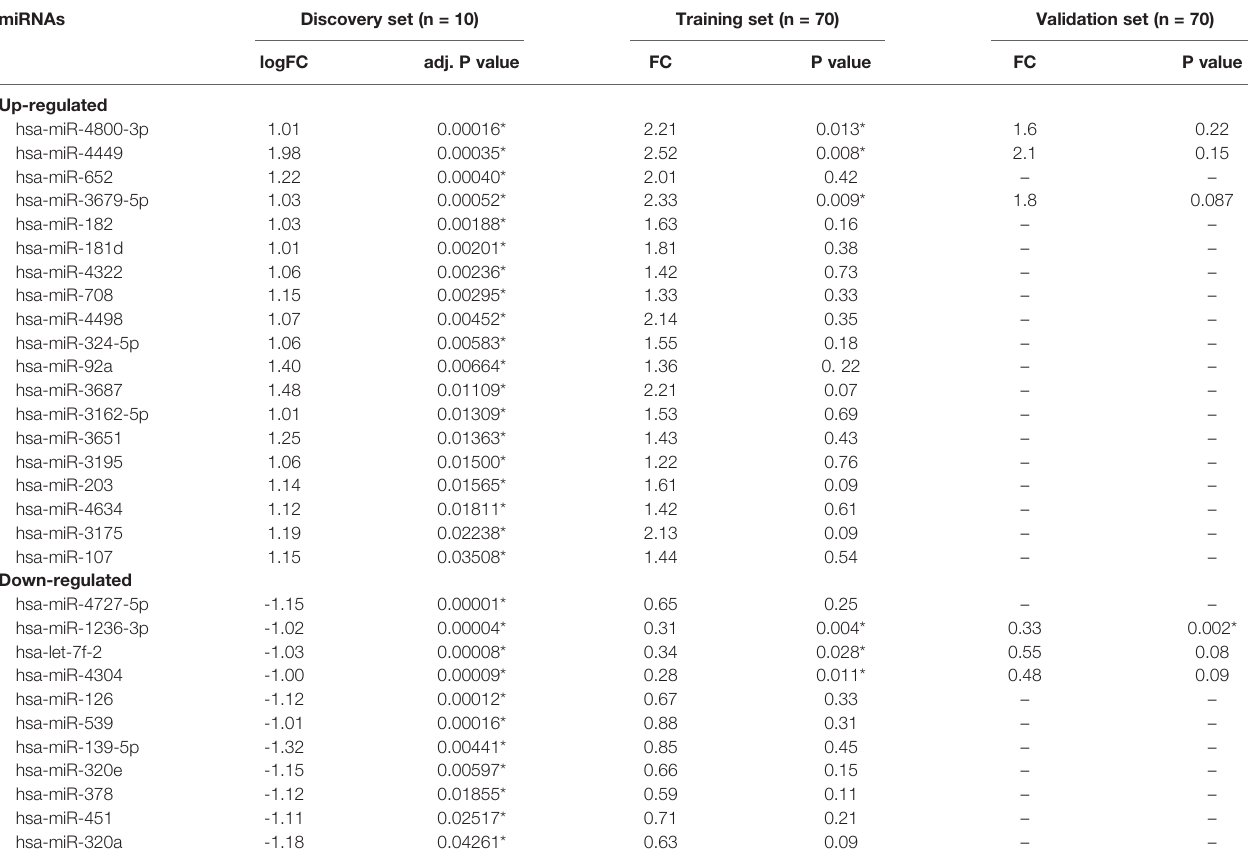
TABLE 3 | Differently expressed miRNA expressions in colon cancer and normal colon tissues in discovery, training and validation sets.